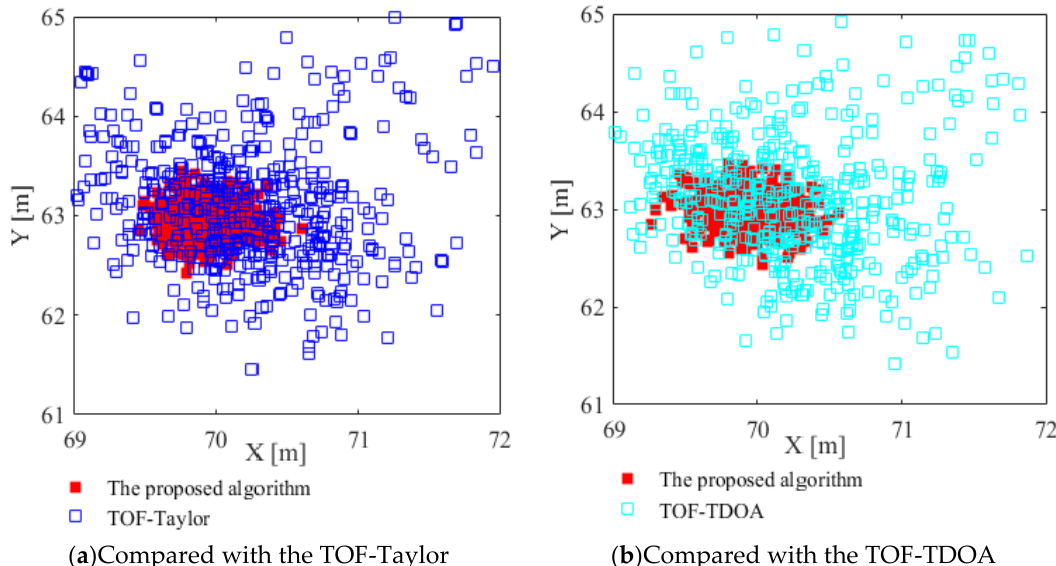
Figure 7. Positioning scatter plots of the tag.